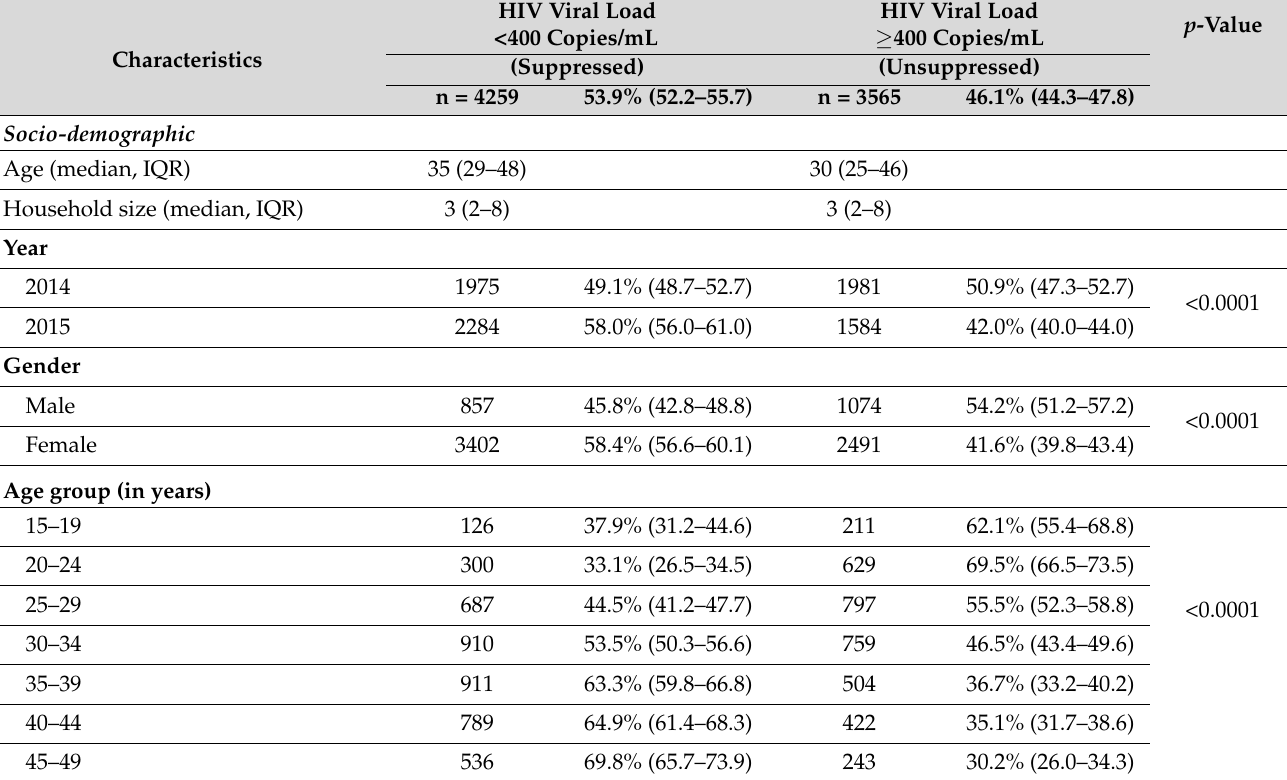
Table 1. Prevalence of unsuppressed HIV viral load by participant characteristics among HIV-positive men and women in Vulindlela (rural) and Greater Edendale (peri-urban) areas in the uMgungundlovu District, KwaZulu-Natal Province, South Africa. HIV Viral